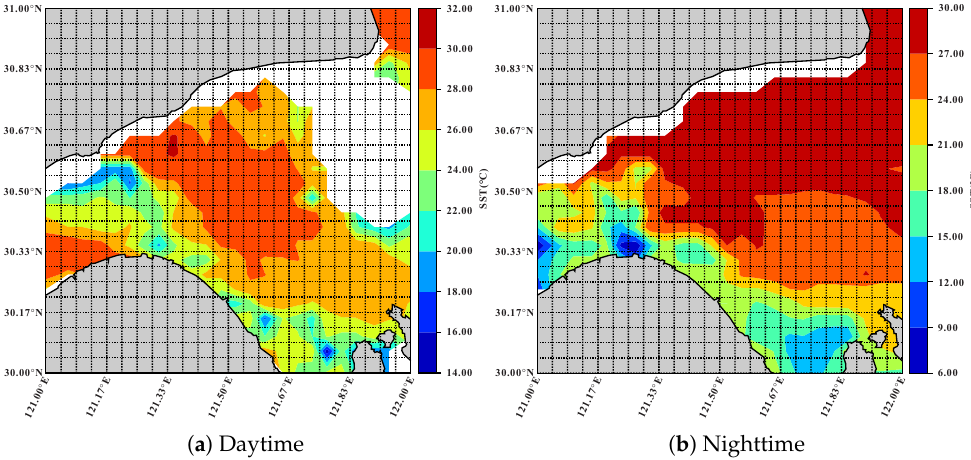
Figure 2. The spatial distribution of SST-EAST dataset on Jul 18, 2021, where the white areas have no data, and the gray areas are land.